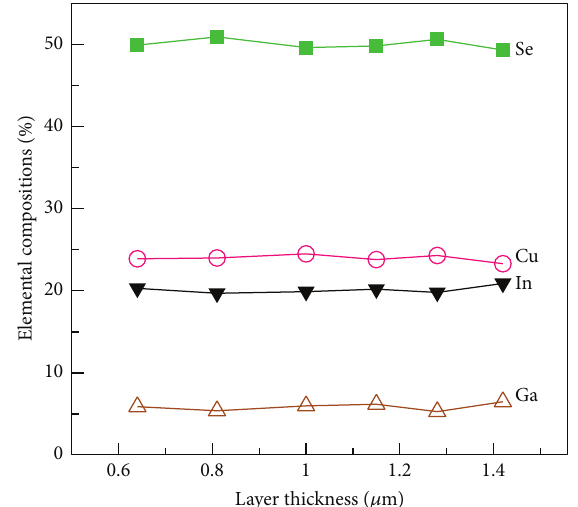
Figure 11: The XRF detailed compositional uniformity of Cu, In, Ga, and Se in the CIGS sample annealed at 550 ∘ C for 20